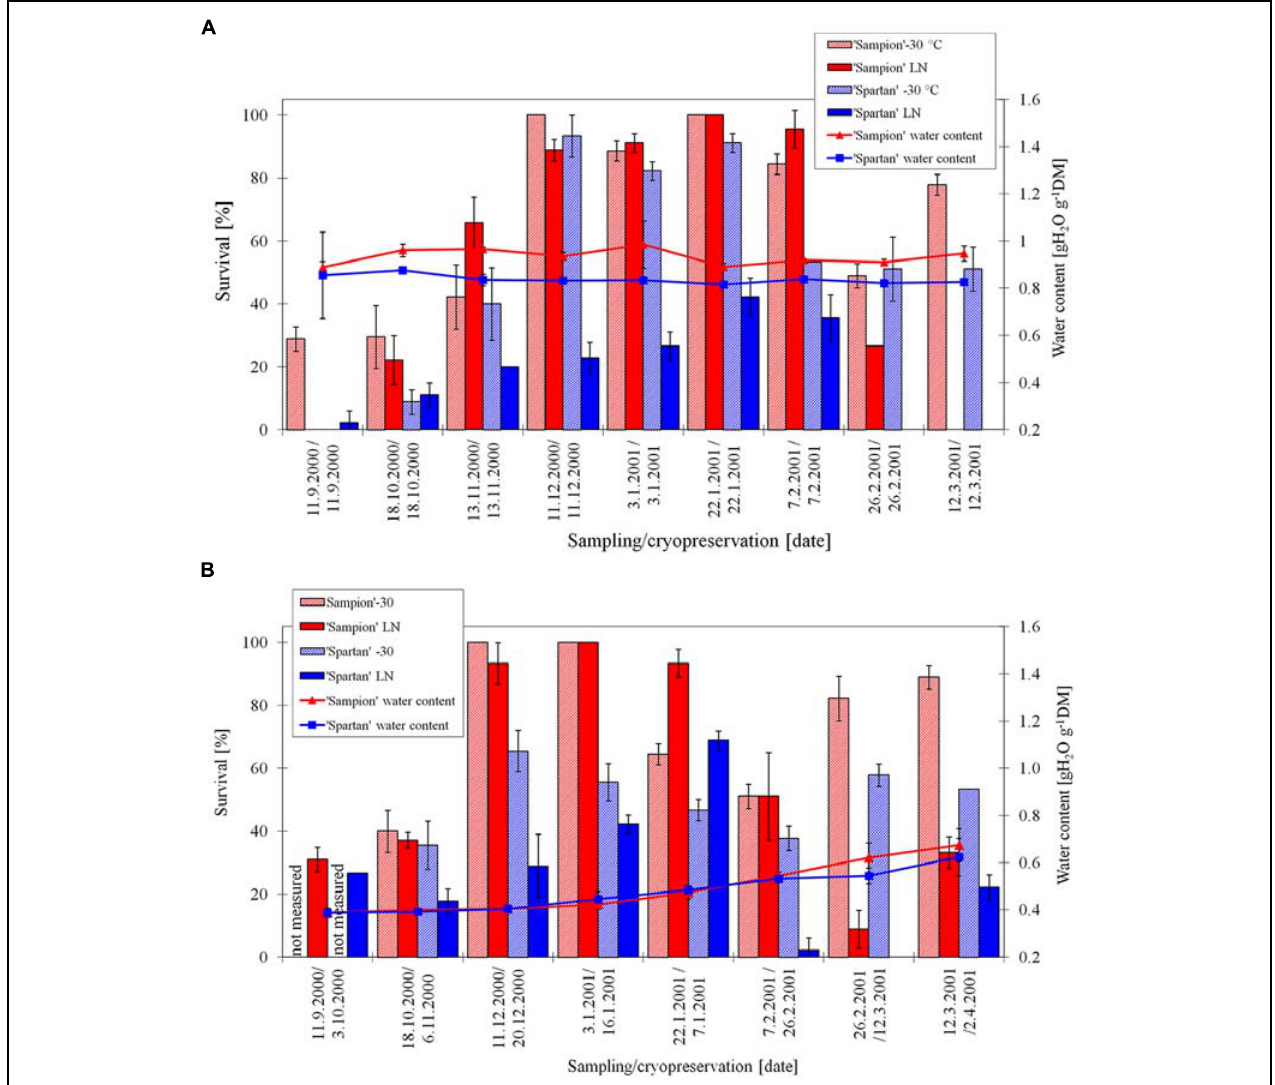
FIGURE 6 | Survival and water content of non-dehydrated (A) and dehydrated (B) vegetative buds of apple cultivars ‘Sampion’ and ‘Spartan’ (B) in the seasons of 2000/2001. ND variant was cryopreserved immediately after sampling from the orchard. D variant was cryopreserved after frost dehydration of at least 1 week at –4 ◦ C. Survival was evaluated after the first step of cryopreservation protocol at –30 ◦ C (–30), and after the second step, reaching the LN temperature. Survival was tested by examination of oxidative browning of tissues on the longitudinal cut of the bud. Water content was measured immediately before cryopreservation procedure. Bars indicate SD ( p <